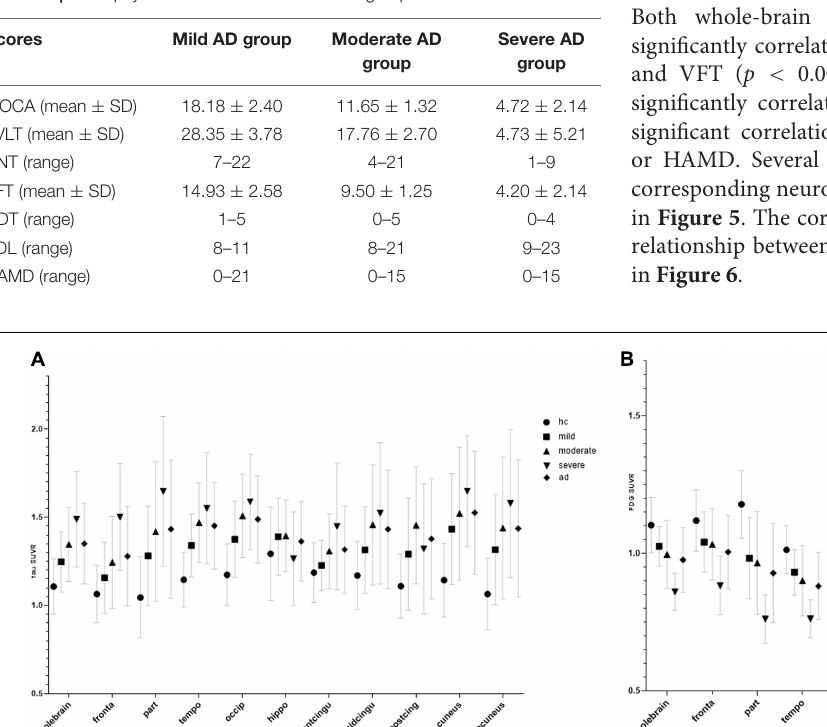
TABLE 2 | Neuropsychiatric scores of different subgroups.